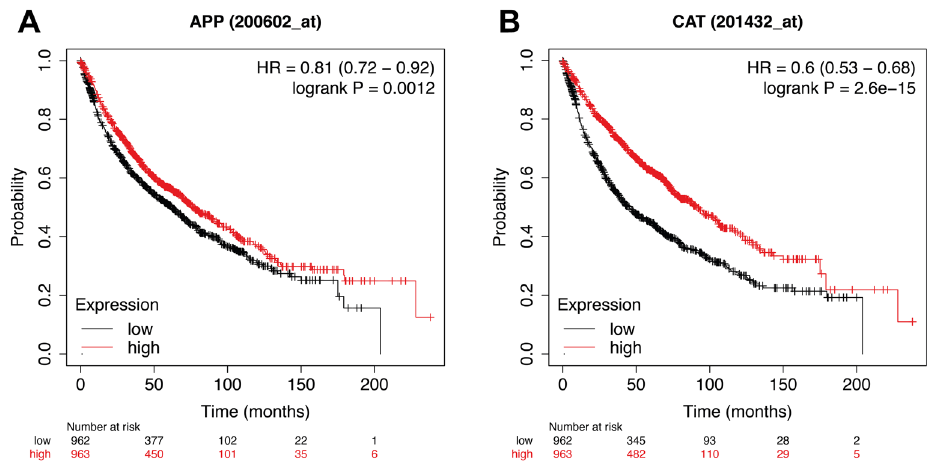
Figure 5. Prognostic values of two hub genes in the brain metastases from SCLC patients. Kaplan–Meier survival analysis of 2 hub genes in patients with small-cell lung cancer. The prognostic value of ( A ) APP and ( B ) CAT for determining the prognostic value of APP and CAT mRNA expression were evaluated using the Kaplan– Meier plotter. The Affymetrix IDs of the genes are as follows: 200602_at ( APP ) and 201432_at ( CAT ). Logrank test for Kaplan–Meier analysis reveals the p -value for both APP and CAT survival analysis. APP and CAT were specifically represented among lung metastasis samples. The patients survive probability with a high expression of hub genes indicated as red-line, and patients survive probability with a low expression of hub genes indicated as black-line. The high and low-expression cohorts were divided by the median survival